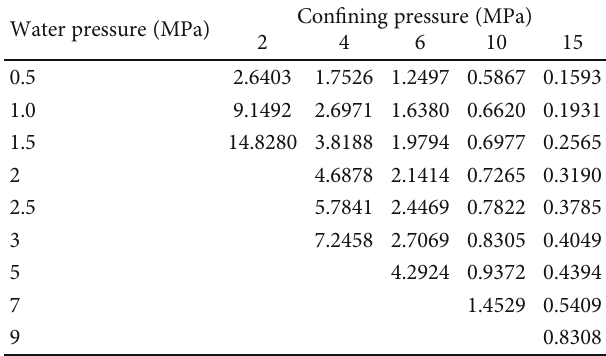
Figure 12: Sample characteristics for achieving single-fracture seepage. Table 3: Test value of permeability coe ffi cient of CS-1 sample (unit: × 10 − 8